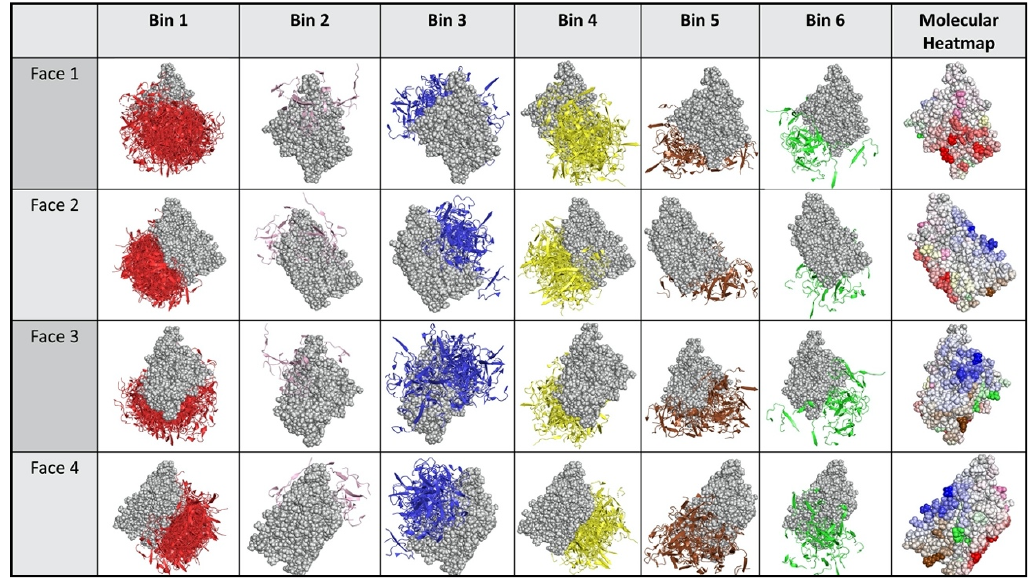
Figure 4. Binned docking models for Abs vs. gD2. Clusters of docking models are arranged in a table format, with each column a different cluster and each row a different perspective. Face #1 is the nectin binding face. Faces #2–4 are rotated by 90, 180, and 270 degrees around the y -axis. The rightmost column is an antigenic heat map (see also Figure 6) where residues are colored by community and shaded so that residues with more Ab interactions are colored more darkly.